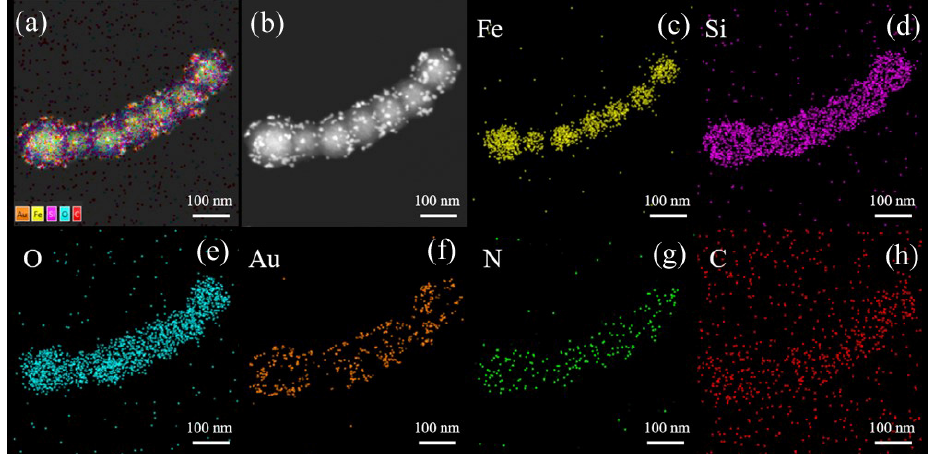
Figure 2. TEM images of high-angle annular dark-field scanning ( a,b ) and element distribution of Fe ( c ), Si ( d ), O ( e ), Au ( f ), N ( g ), and C ( h ) elements of the Fe 3 O 4 @SiO 2 @Au/PDA nanochain.